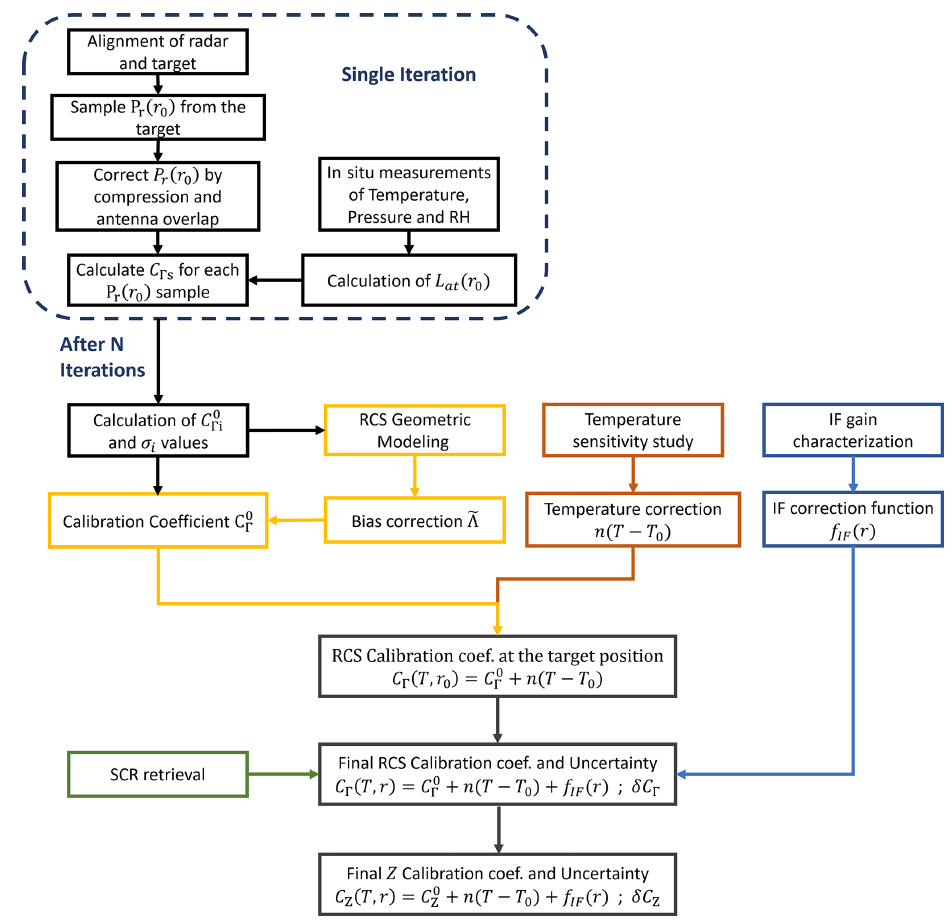
Figure 2. Summary of a complete calibration process. Each calibration requires the repetition of system realignment and sampling steps called iterations. During each iteration, we continuously sample the power reflected from the reference target position for 1h (power cor- rections in Sect. 5.1). The retrieval of N iterations enables the estimation of the system bias due to misalignments in the setup (Sect. 5.6). Temperature dependency is retrieved in an independent experiment (Sect. 5.4). Uncertainty introduced by clutter signals at the target location is also included in the total uncertainty budget (Sect.